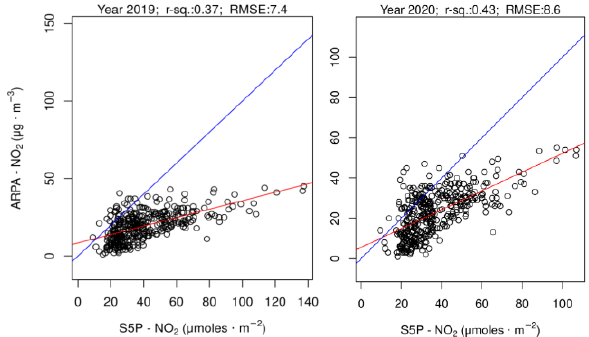
Figure 10. Highest r-squared values ( Table 4) for 2019 (left) and 2020 (right) from municipalities where stations were aggregated.